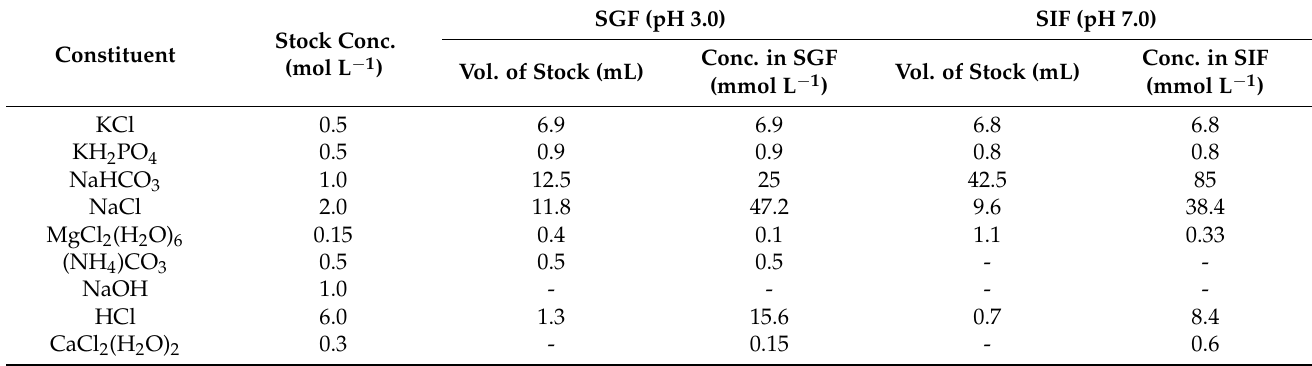
Table 2. The specific formulas of the stock solutions of simulated digestion